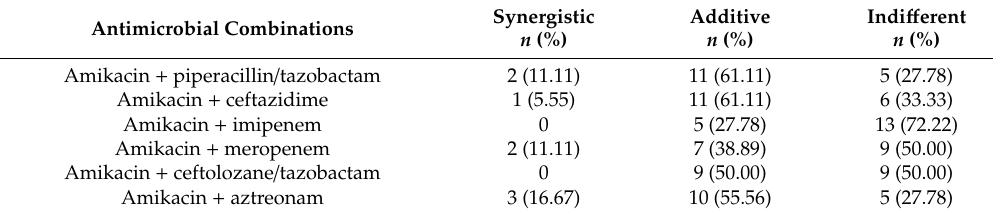
Table 3. Synergistic activity of the antimicrobial combinations of colistin-resistant P. aeruginosa . Antimicrobial Combinations